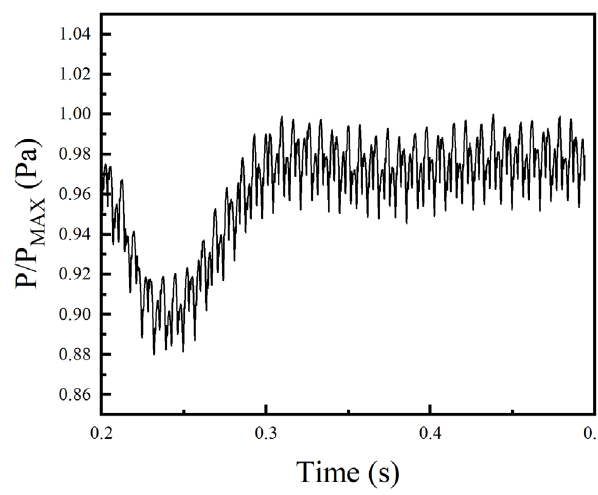
Fig. 18. Calculation results of outlet pressure pulsation of centrifugal pump.